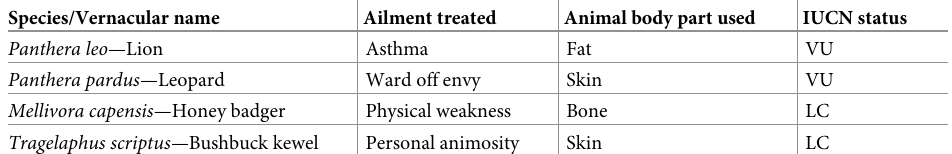
Table 2. Mammal species and their respective body parts used for medicinal and “magical” purposes within Qui- c¸ama National Park and Quic¸ama Game Reserve, Angola, Southwest Africa.